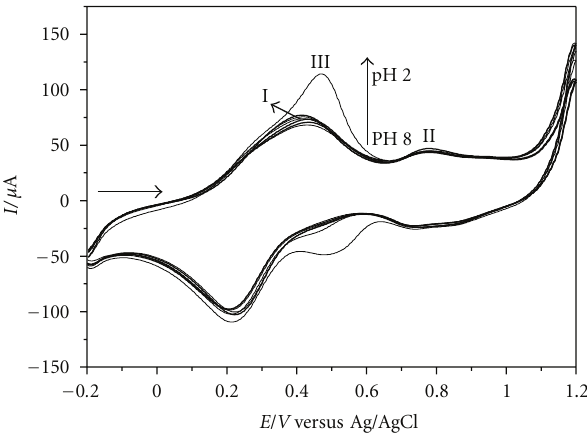
Figure 6: Cyclic voltammograms of CuNPSD at di ff erent pH values